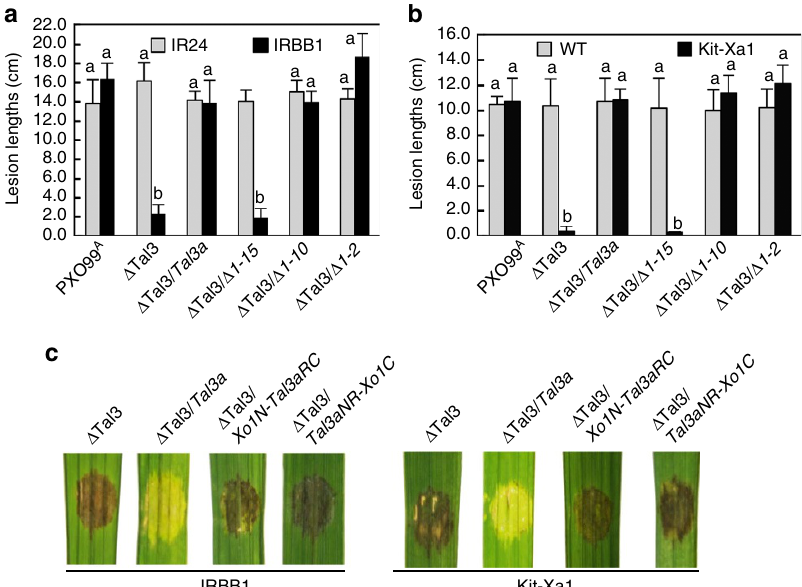
Figure 3 | Unique domains inTal3a are required for its suppressive activity. ( a ) Lesion lengths in IRBB1 and IR24 caused by Xoo strains as indicated below each column at 14 DPI. D 1-15, D 1-10 and D 1-2 represent Tal3a with the N-terminal 15, 10 and 2 repeats deleted, respectively. ( b ) Lesion lengths in Kitaake (WT) and Xa1 transgenic plants as assessed similarly in a but at 12 DPI. ( c ) Both Tal3a N-terminal and C-terminal structures are required for suppression of Xa1- mediated HR triggered by D Tal3. Xo1N-Tal3aRC is a Tal3a variant containing PthXo1 N terminus and Tal3a central repetitive and C-terminal domains. Tal3aNR-Xo1C is a hybrid of Tal3a N-terminal and repetitive domains and PthXo1 C terminus. Photos were taken at 3 DPI. Error bars (s.d., n ¼ 12, 2 replicates) with the same letter do not differ from each other at P o 0.05 (Tukey’s